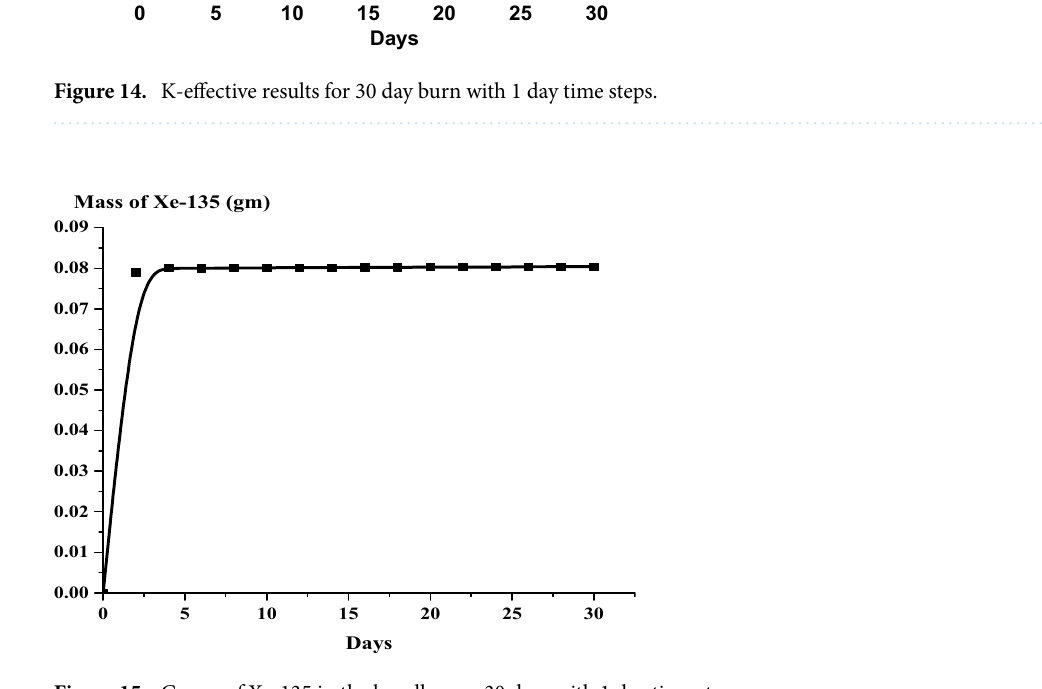
Figure 15. Grams of Xe-135 in the bundle over 30 days with 1 day time